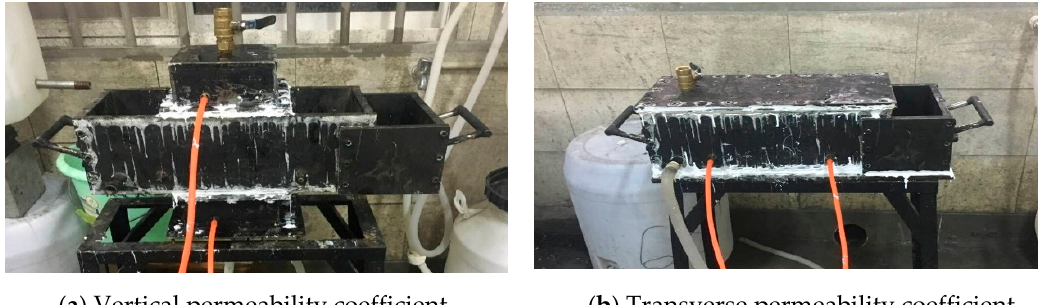
Figure 4. Permeability test.